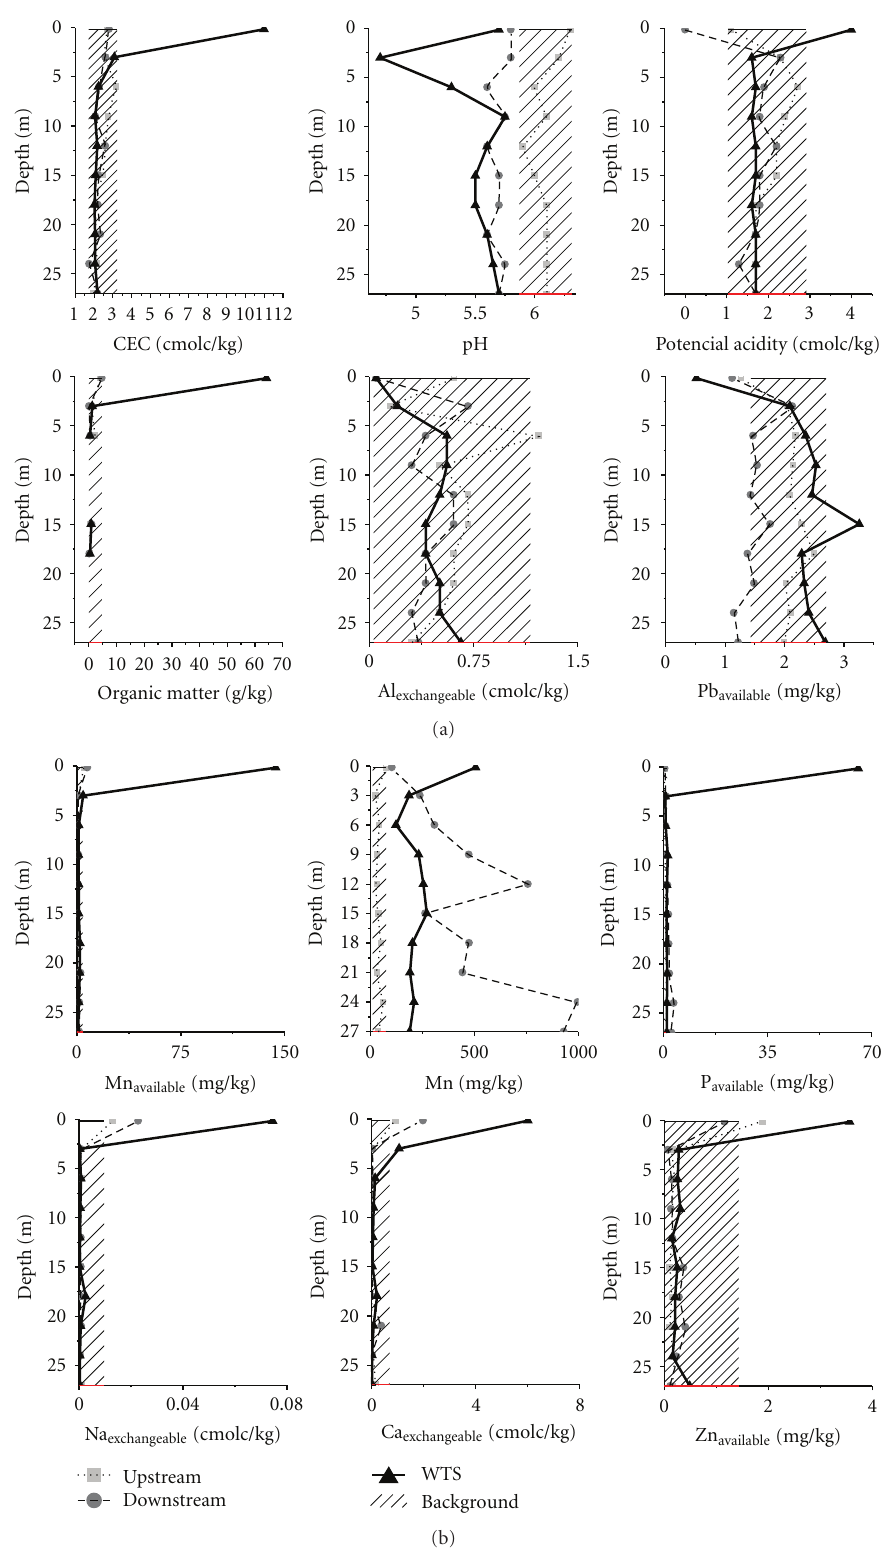
Figure 3: Vertical profiles of various parameters analyzed in samples obtained from monitoring well drillings. Highlighted bands on each graph correspond to background levels (range of two standard deviations of the samples average value from the control area—Upstream monitoring well). (a) Results of potential acidity, CEC, pH, organic matter, exchangeable-Al, and available-Pb; (b) Results of Mn, available- Mn, available-P, available-Zn, exchangeable-Na, and